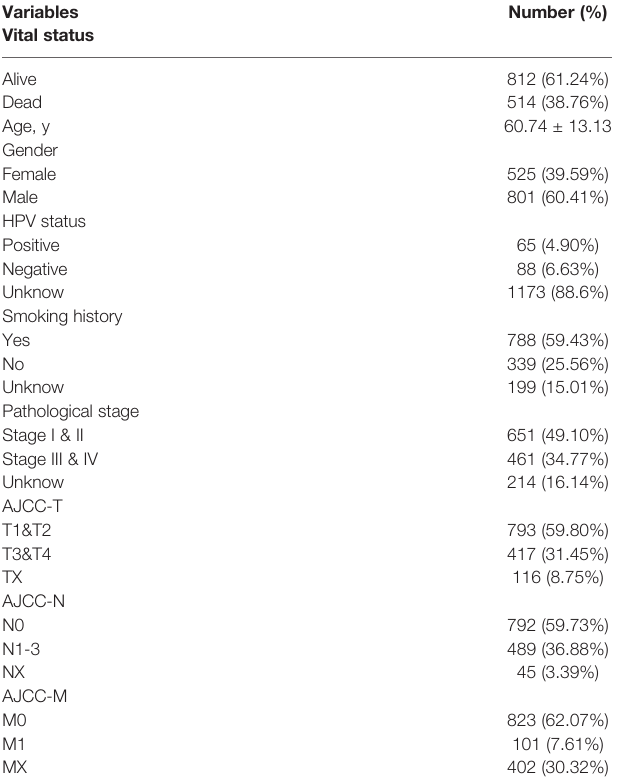
TABLE 1 | Clinical characteristics of 1326 patients with SCC from TCGA